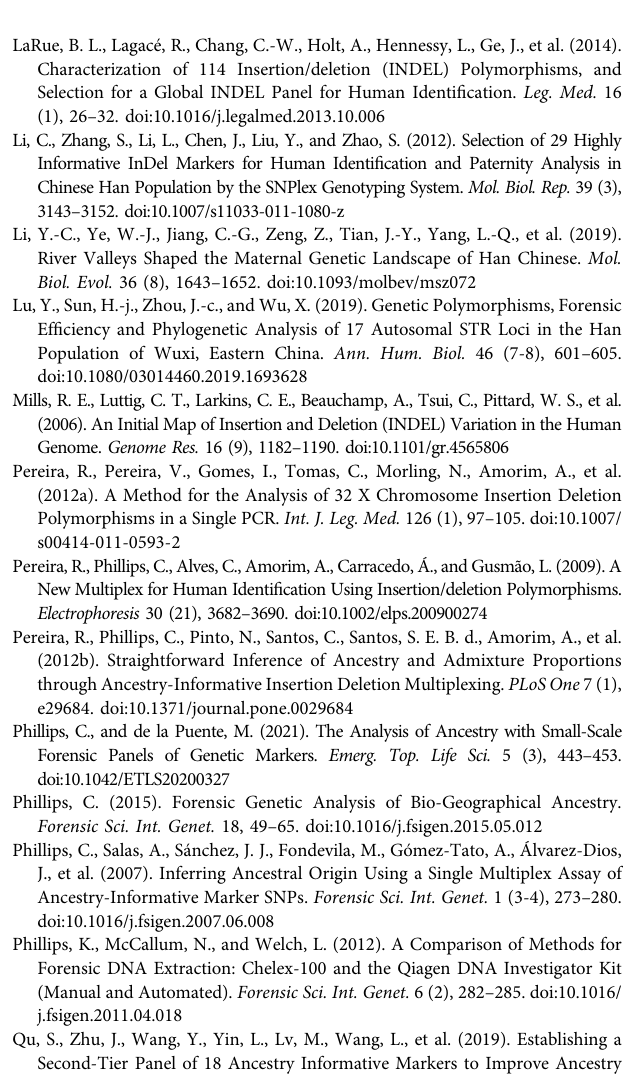
Supplementary Figure 1 | Pairwise In values of fi ve continental populations for 50 ancestry informative DIPs. Supplementary Figure 2 | Cumulative PSD values of 50 ancestry informative DIPs in different continental populations. Supplementary Figure 3 | Ancestry origin analyses of different continental populations by the Snipper 2.5 online